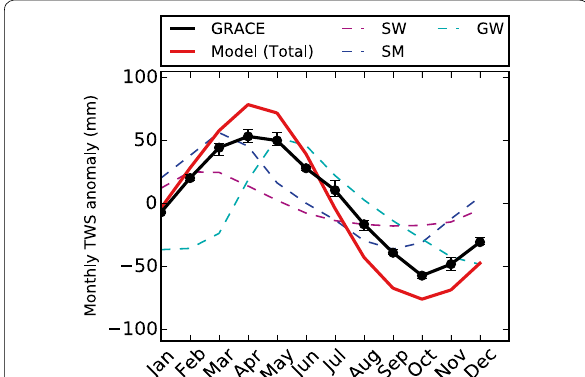
Fig. 2 Comparison of simulated terrestrial water storage (TWS) anomaly with GRACE-based TWS for the combined area of Amu Darya and Syr Darya river basins, averaged for the period 2003–2010. SW, SM, and GW denote the contributions from surface water, soil moisture (in the vadose zone), and groundwater (below the water table) to the simulated total TWS ( red line ). The GRACE data are shown as the mean of the products from three processing centers, namely Center for Space Research at University of Texas, Austin (CSR), Jet Propulsion Laboratory (JPL), and Geoforschungs Zentrum Potsdam (GFZ), with the error bars showing the range of variations between the three